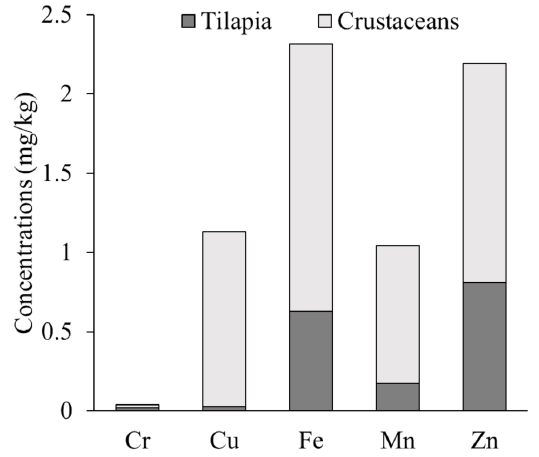
Figure 4. Contribution of crustaceans and tilapia to the mean EDI. Table 7. Potential health hazard index (HHI) by ingestion of aquatic resources from Marinduque. Location